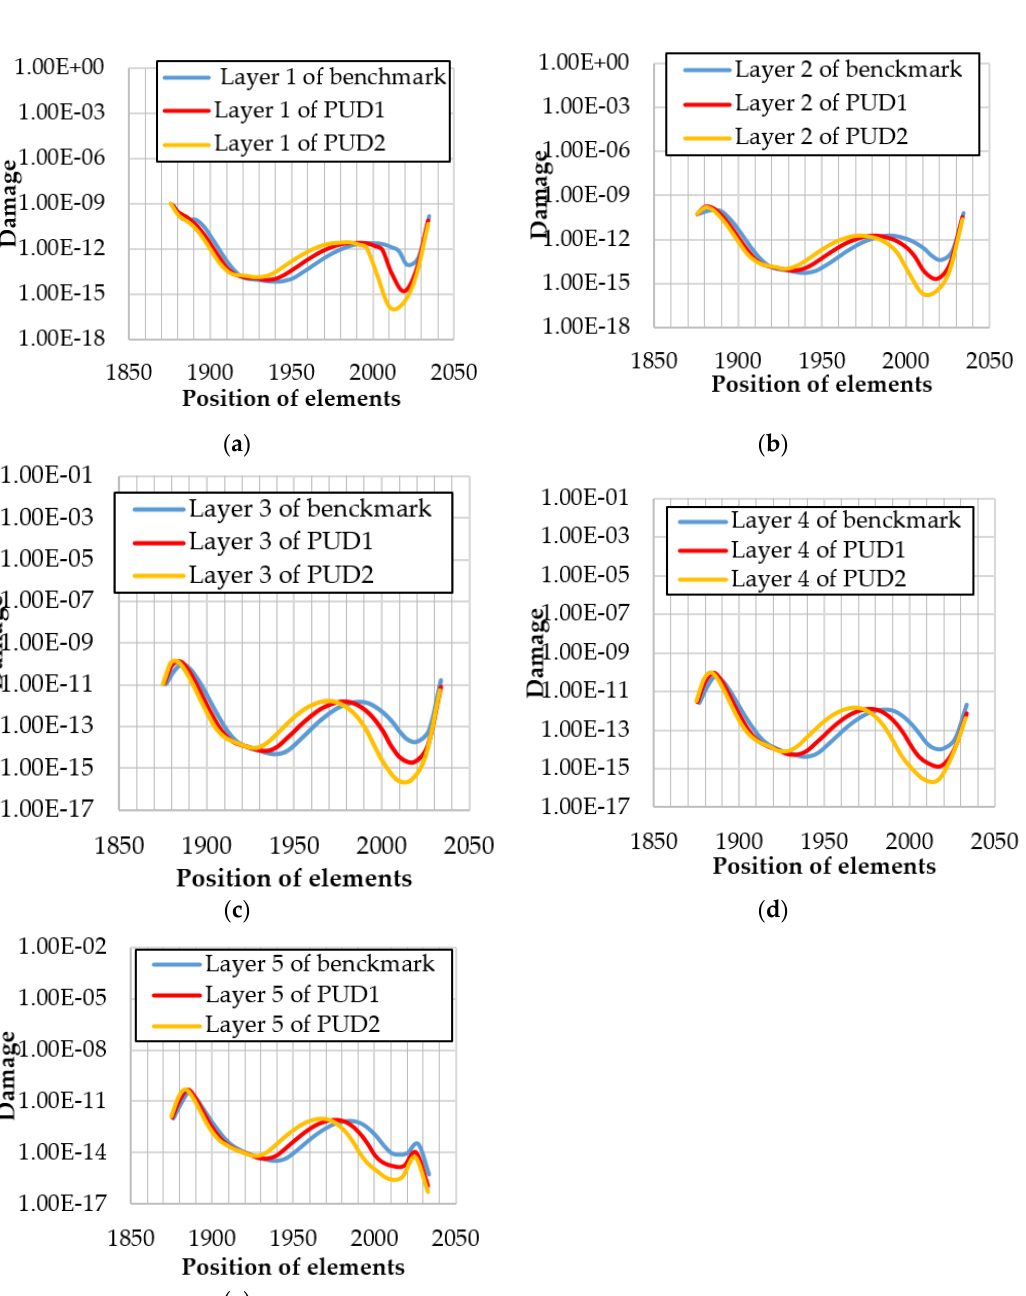
Figure 18. Comparison of the benchmark and PUD models on each layer: ( a ) Comparison of the results of layer 1 in each model; ( b ) Comparison of the results of layer 2 in each model; ( c ) Comparison of the results of layer 3 in each model; ( d ) Comparison of the results of layer 4 in each model; ( e ) Comparison of the results of layer 5 in each model;.